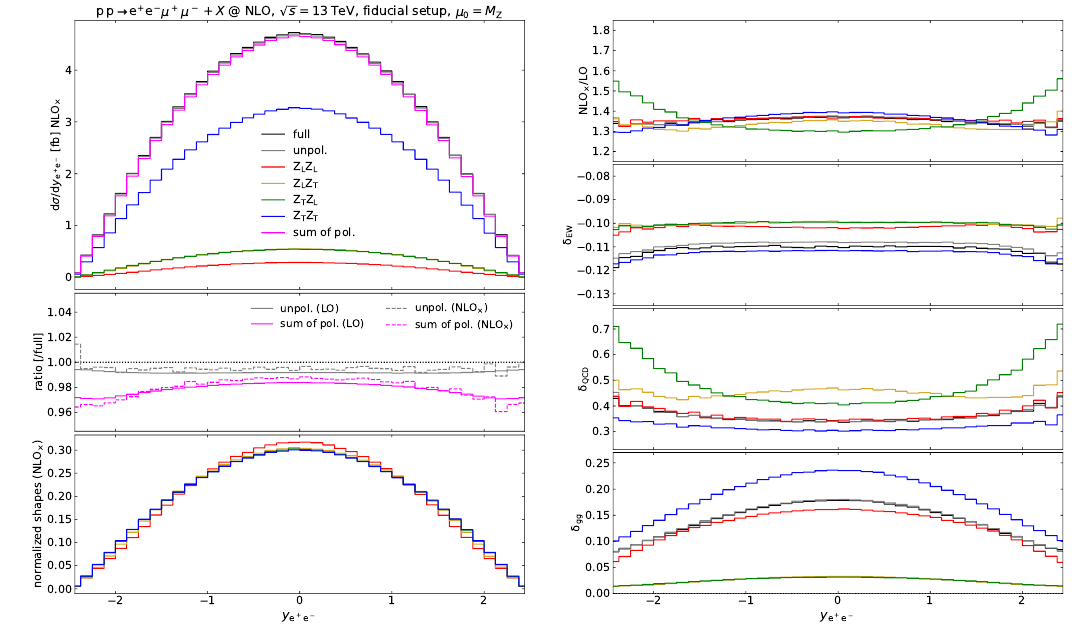
Figure 16 . Distributions in the rapidity of the e + e − pair (single Z boson). Same structure as in figure